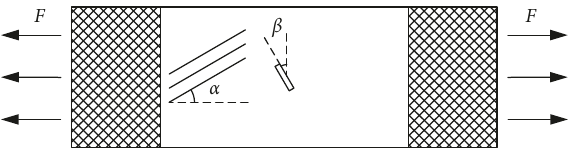
Figure 6: Pictures and schematic of two plates with defects. (a) Plate with a hole. (b) Plate with a line crack. F F